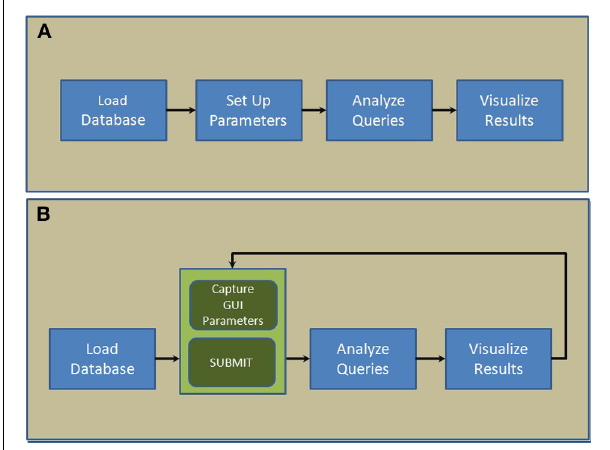
FIGURE 1 | Scripting architecture of the 2-step paradigm used to develop NNE 1.0. (A) The first step where 4 core modules are put together sequentially. (B) The second step where a new GUI-based module captures parameters and displays results interactively.